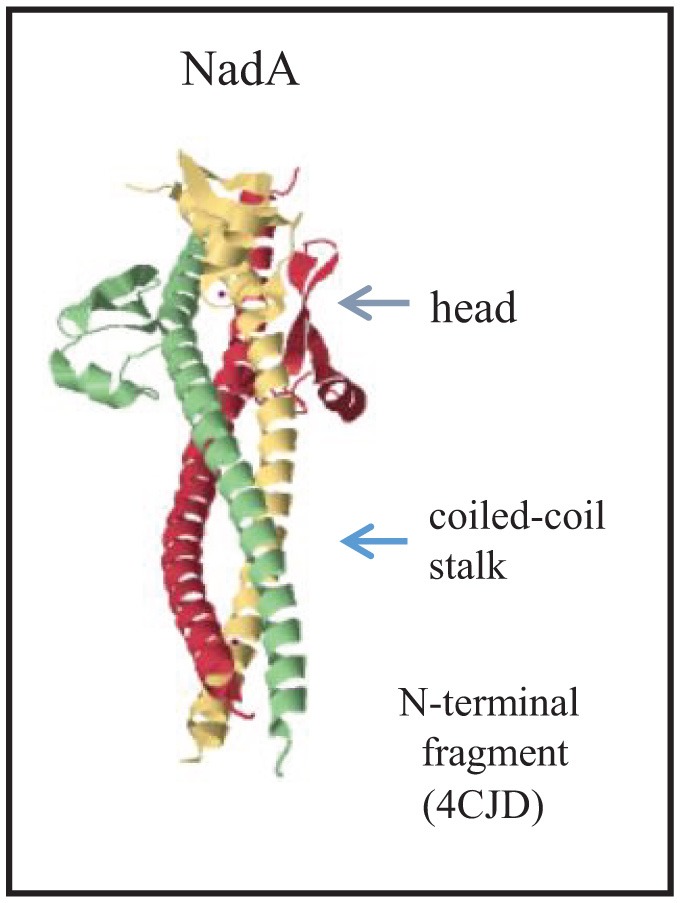
Structure of the passenger of the trimeric autotransporter NadA. The structure of the N-terminal part of the passenger is provided (Malito et al., 2014). Each subunit is colored differently, and the major structural domains of the complex are indicated. The PDB access code is provided in brackets.